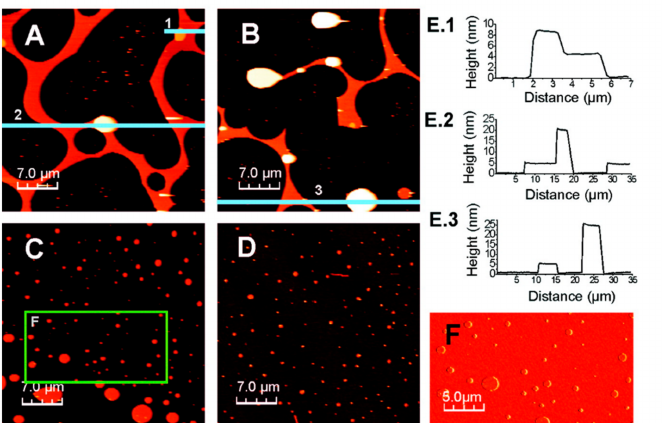
Figure 4. AFM topography images of spin-coated samples of DOPC in air prepared with di ff erent concentrations of lipid in the coating solution in the range 0.1–1 mM. ( A ) 0.75 mM, ( B ) 0.5 mM, ( C ) 0.25 mM, and ( D ) 0.1 mM (35 × 35 µ m 2 , Z -scale: 30 nm). ( E ) Profiles corresponding to the cross-section line shown in images A (1,2 are E.1 and E.2, respectively) and B (3 is E.3), and ( F ) phase image of the marked area in image C. (Reproduced with permission from reference 68, copyright 2011 American Chemical